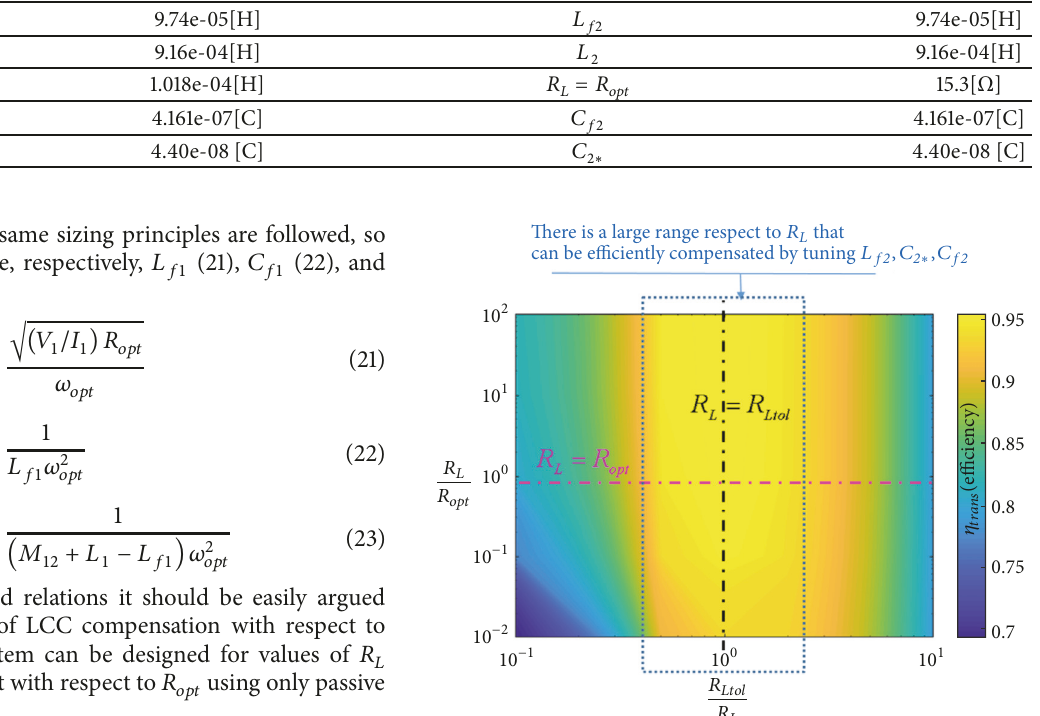
/ R and R / R . L opt Ltol opt